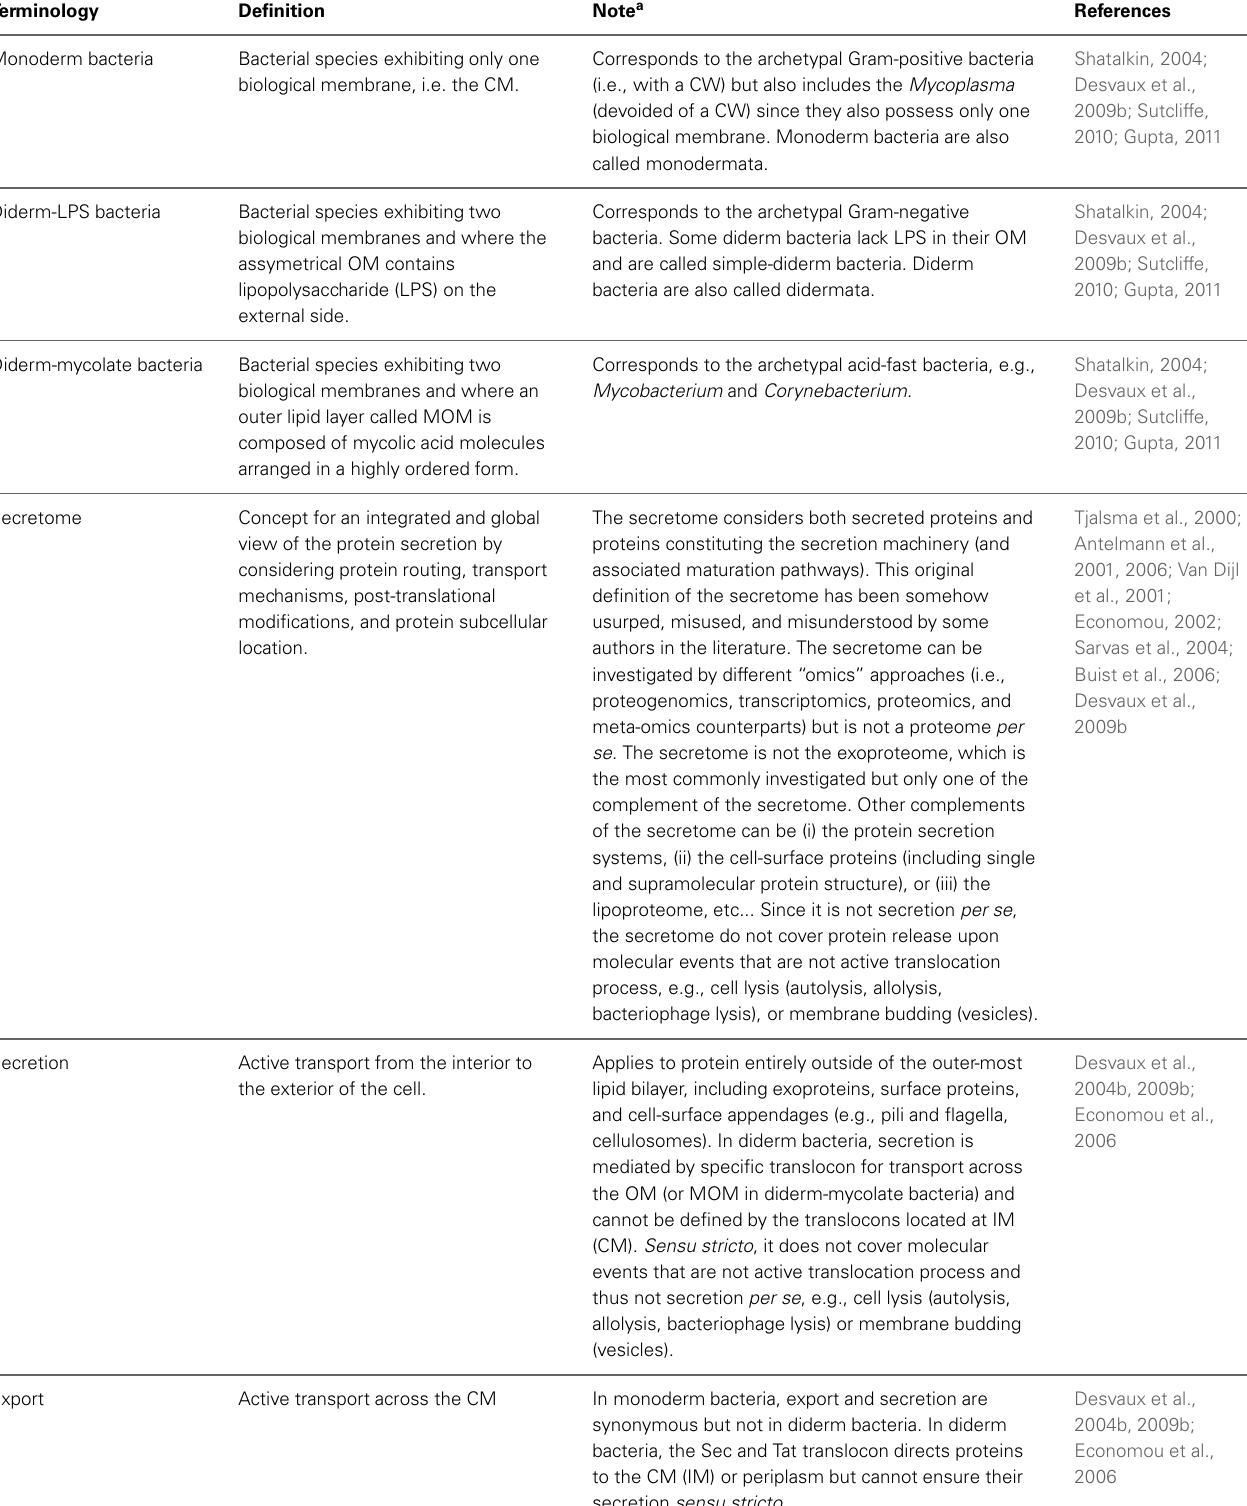
Table 1 | Some key definitions in the field of bacterial protein